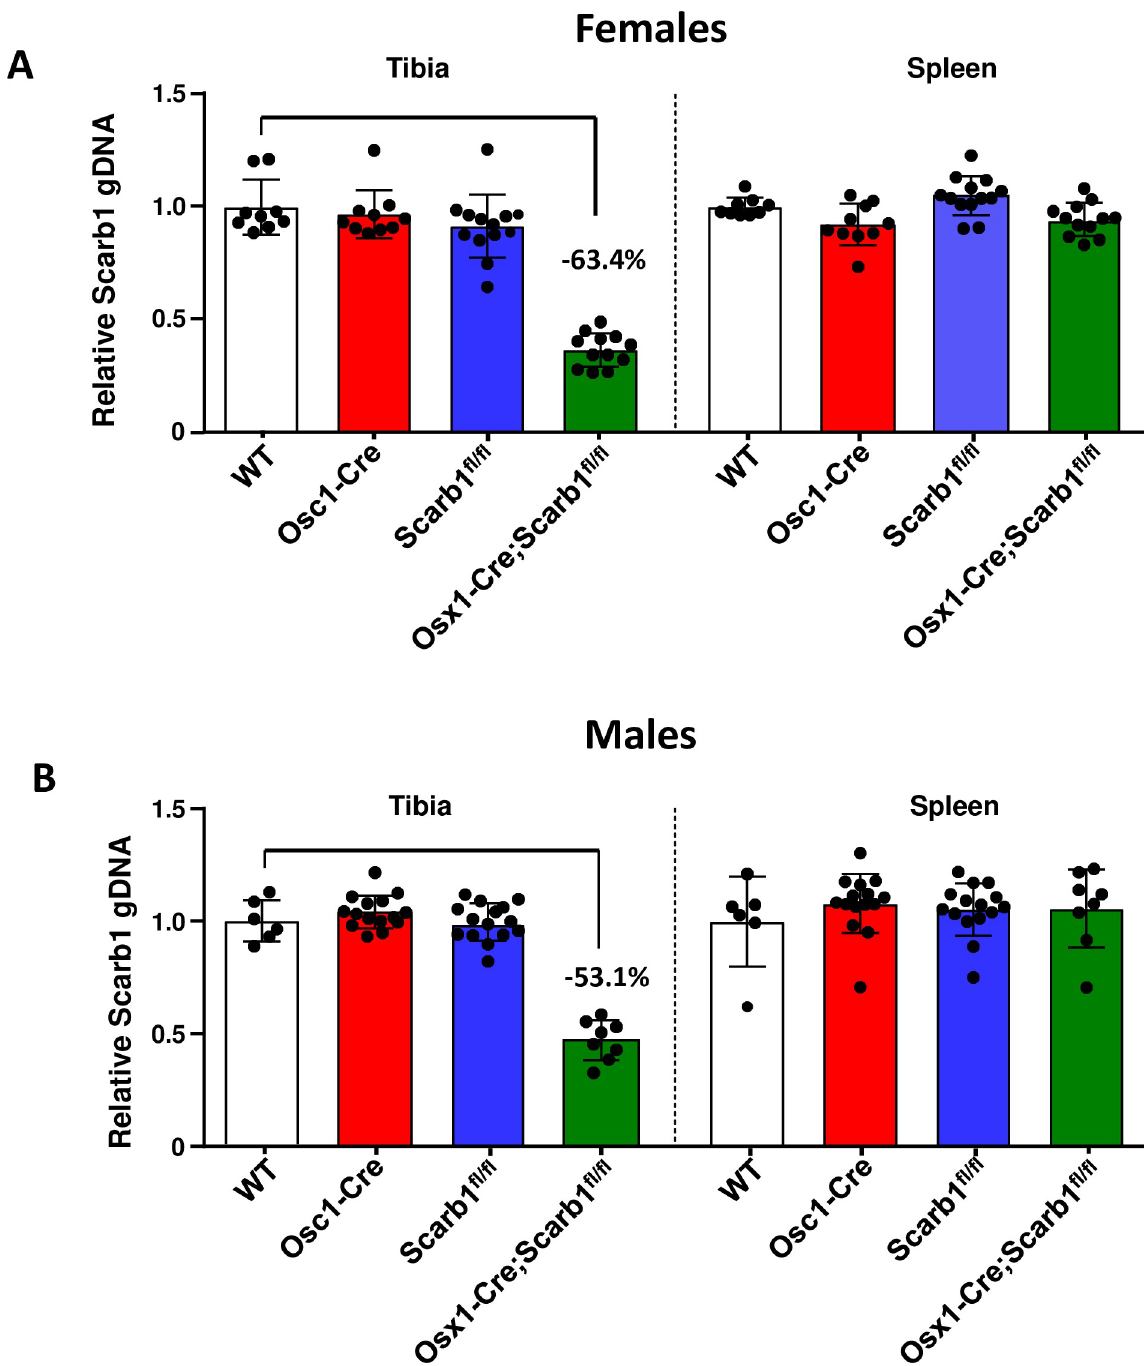
Fig 2. Scarb1 gene was effectively deleted in bone. Quantitative PCR (qPCR) of loxP-flanked genomic DNA isolated from tibial cortical bone and spleen. (A) 6 month-old female mice [WT (n = 9), Osx1-Cre (n = 10), Scarb1 fl/fl (n = 13), Osx1-Cre;Scarb1 fl/fl (n = 12)]. (B) 7-month-old male mice [WT (n = 6), Osx1-Cre (n = 15), Scarb1 fl/fl (n = 15), Osx1-Cre;Scarb1 fl/fl (n =